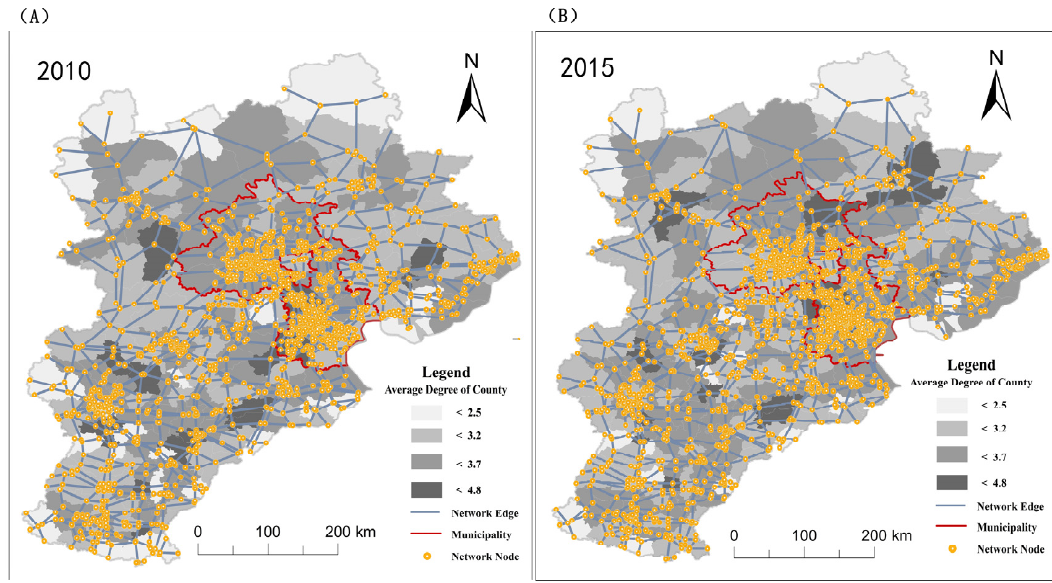
Figure 6. Road network in the BTH urban